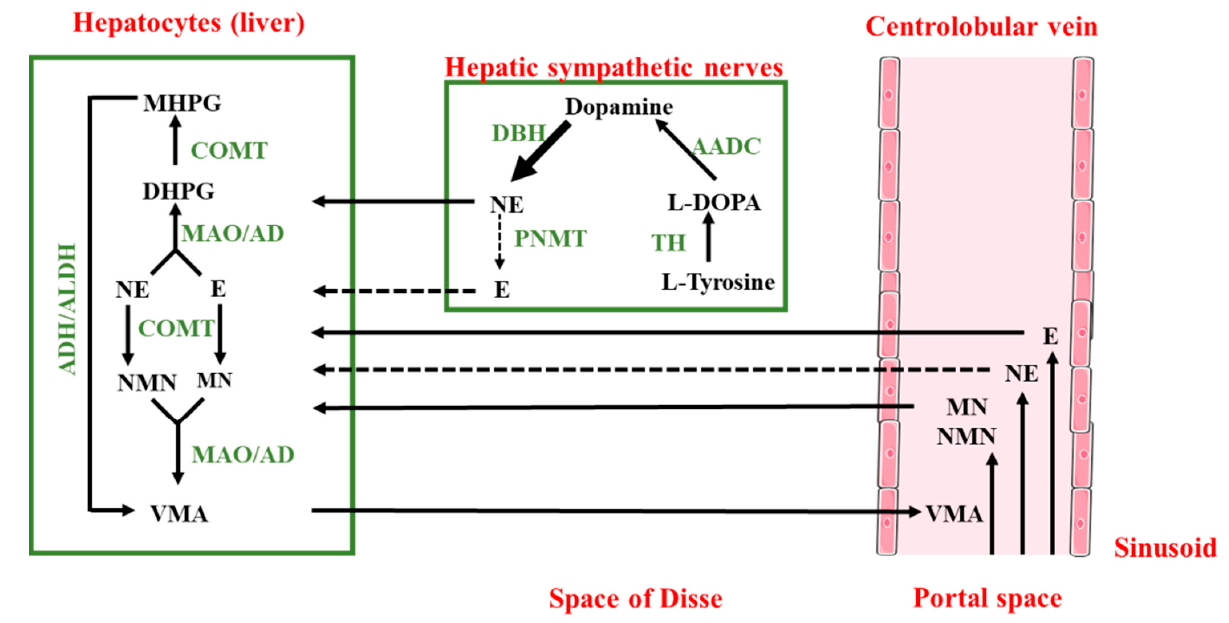
Figure 1. Metabolism of epinephrine (E) and norepinephrine (NE) in the liver. Adrenal glands, mesenteric organs, and liver sympathetic innervation are the main sources of E and NE in the liver. The last step of metabolism for metanephrine (MN) and normetanephrine (NMN) extracted from the circulation are also performed in the liver. Thus, E, NE, MN, and NMN are uptaken by hepatocytes and metabolized in VMA. VMA is then eliminated in the urine. AD: aldehyde reductase; ADH: alcohol dehydrogenase; ALDH: aldehyde dehydrogenase; MAO: monoamine oxidases; COMT: catechol-O-methyltransferase; TH: tyrosine hydroxylase; AADC: aromatic L-aminoacid decarboxylase; DBH: dopamine- β -hydroxylase; PNMT: phenylethanolamine N-methyltransferase; DHPG: 3,4-dihydroxyphenylglycol; MHPG: 4-hydroxy-3methoxyphenylglycol; VMA: vanillyl mandelic acid (Solid arrow: main pathway; dotted arrow: minor pathway).